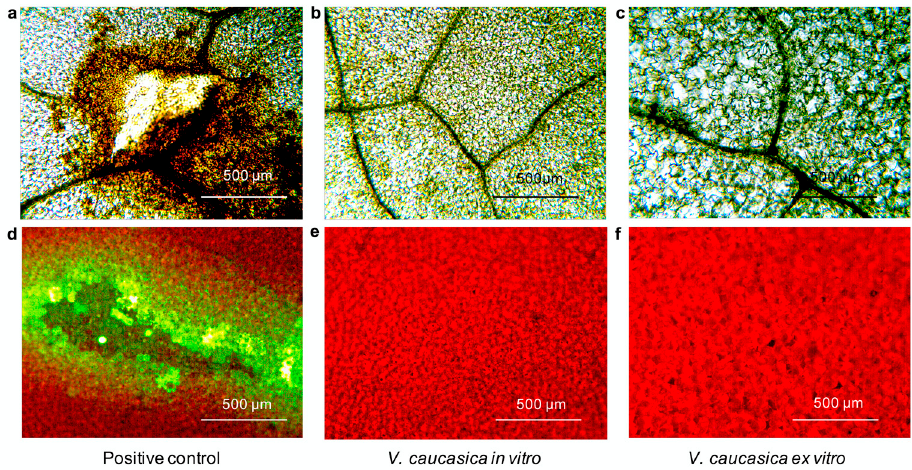
Figure 4. Hydrogen peroxide and ROS accumulation in leaves of in vitro cultivated and ex vitro adapted V. caucasica plants: DAB staining—H 2 O 2 is stained in brown, intensity of the colour corre- sponds to H 2 O 2 amount ( a – c ). Epifluorescence of ROS after staining with DCF-DA. The green fluorescence indicates presence of ROS; Chl fluorescence appears in red ( d – f ). Positive controls, mechanically injured ( a , d ). Scale bar = 500 µ